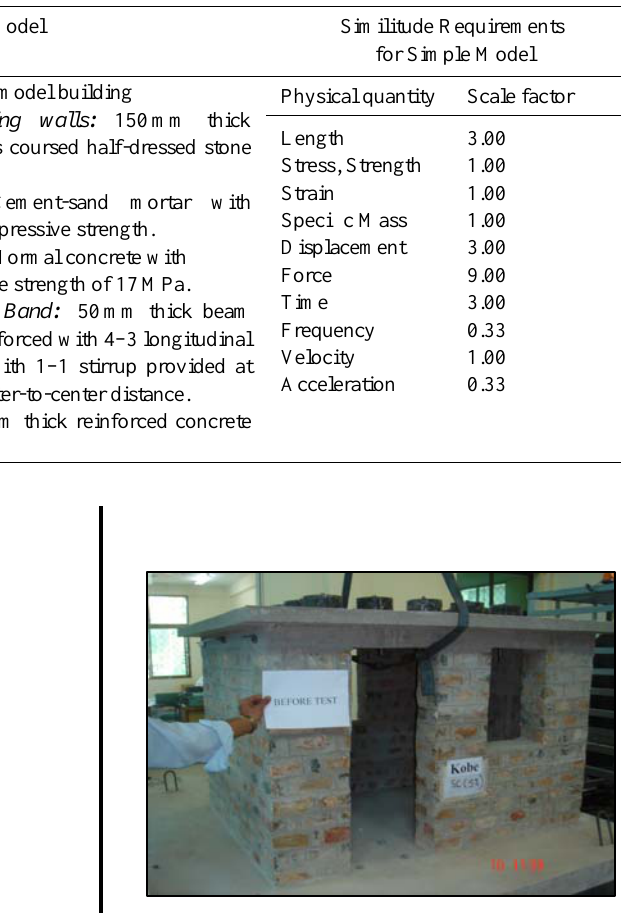
Table 1. Characteristics of the simple test model and similitude requirements for quantities conversion.